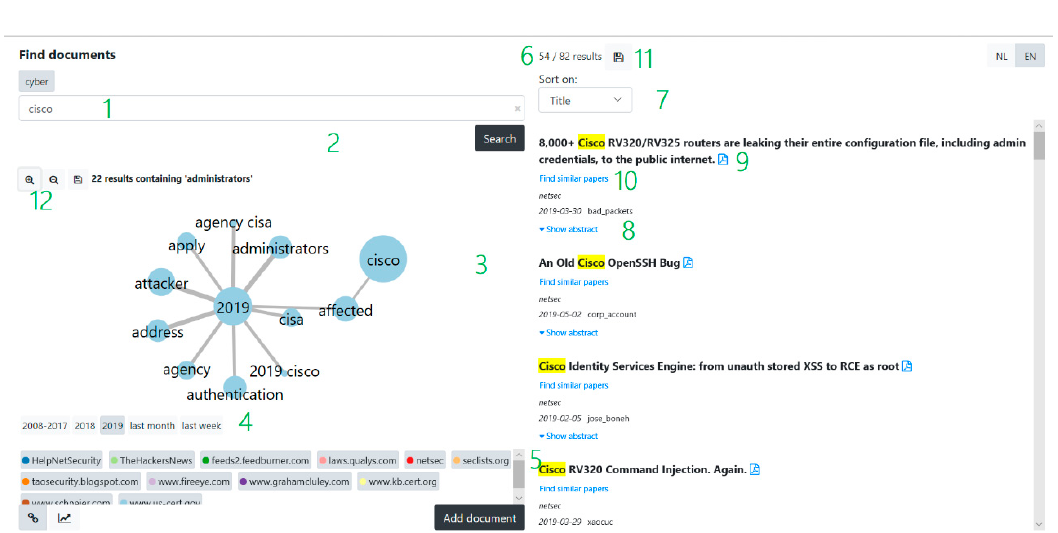
Figure 4. Result screen of the Horizon Scanner tool with the trend analysis.